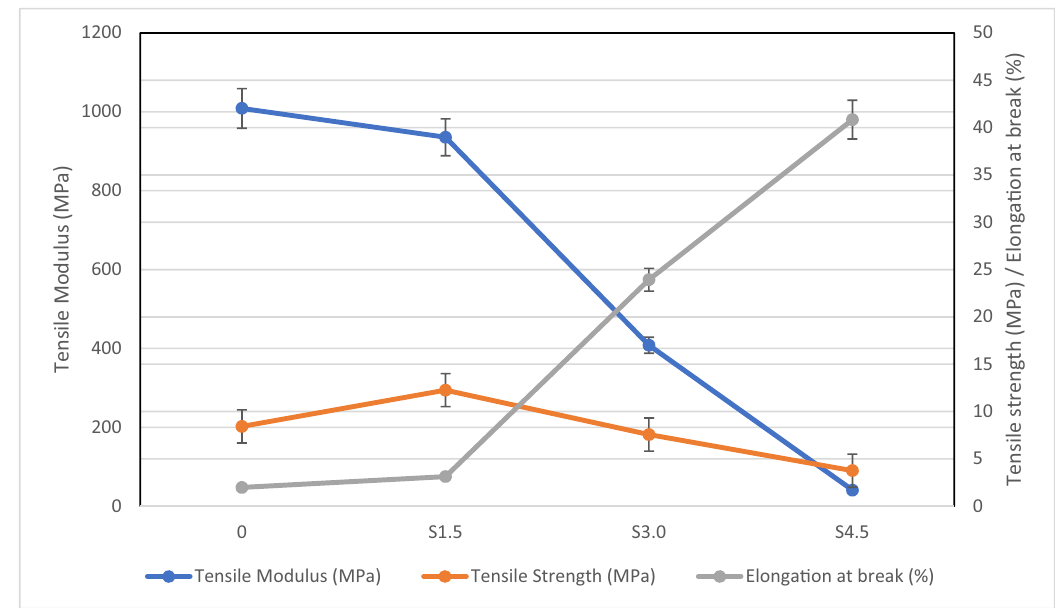
Figure 7: Mechanical properties of S - plasticized fi lms.